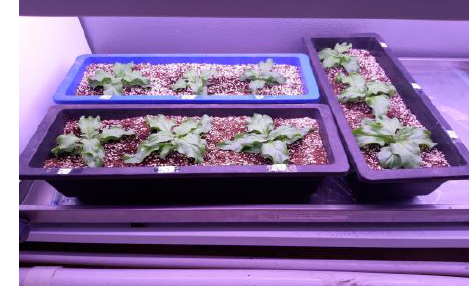
Figure 1. The ice plants ( M. crystallinum ) in the plant factory system under controlled environmental conditions.